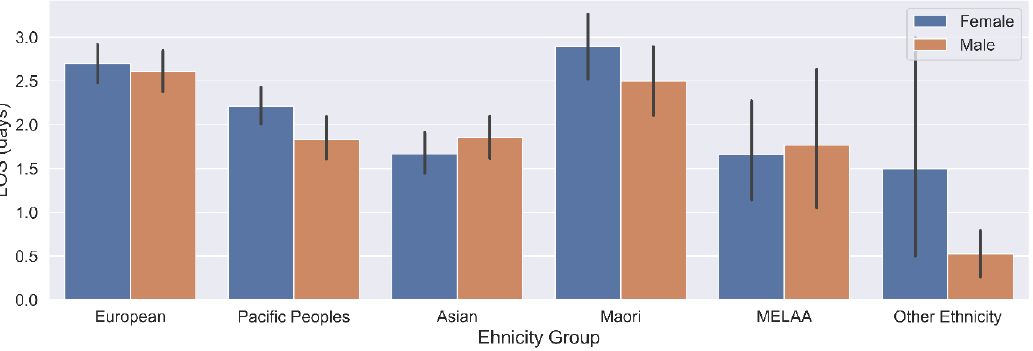
Figure 6. Correlation between ethnicity, average LOS, and gender.